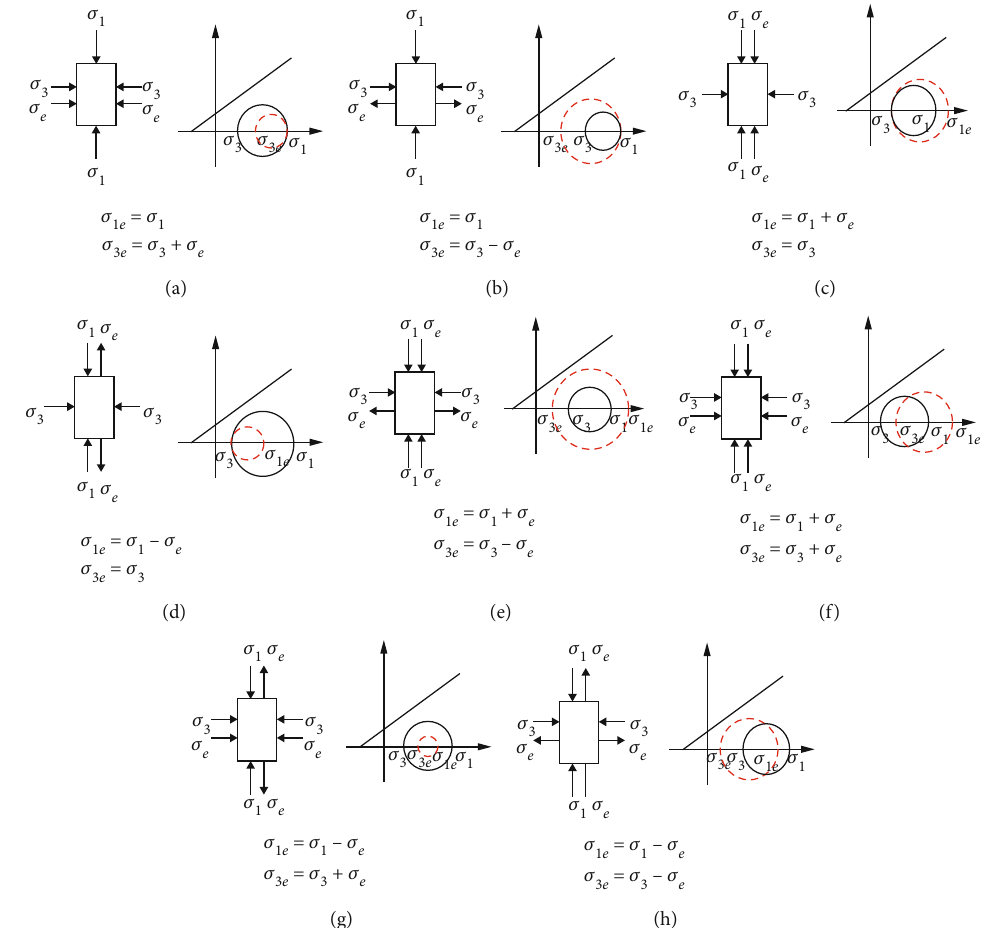
Figure 2: Stress state of rock joints under engineering